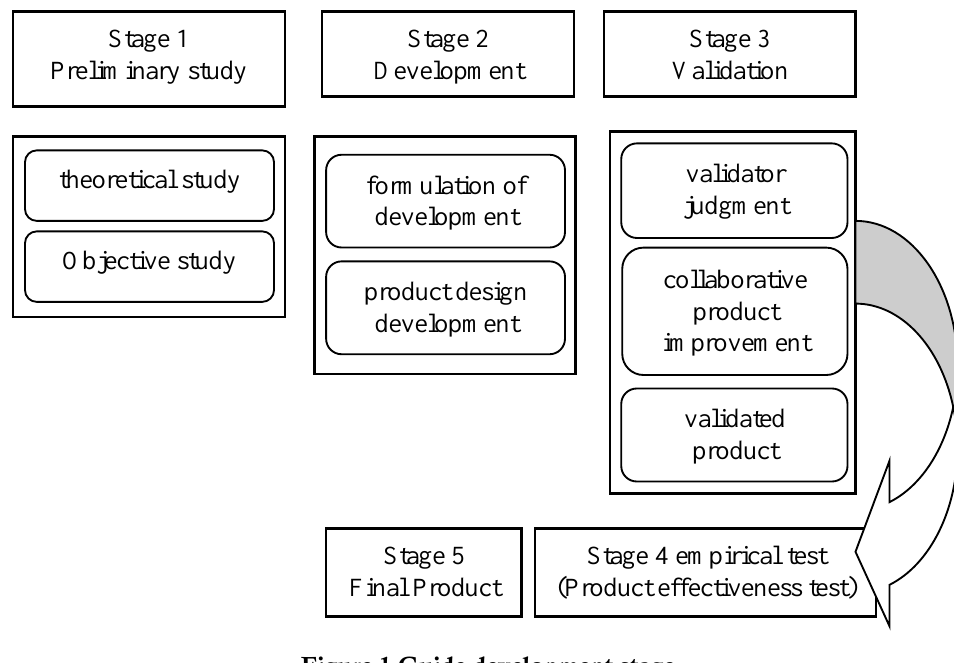
Figure 1 Guide development